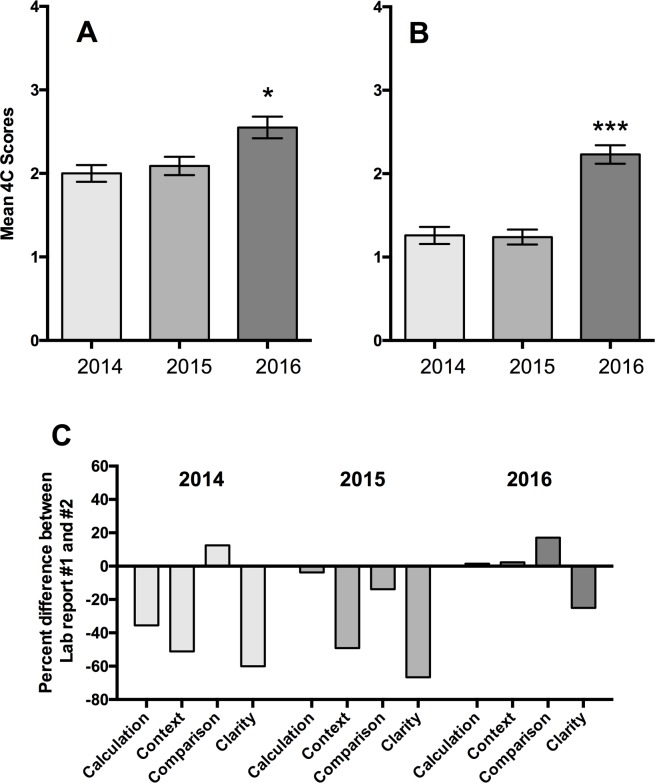
Analysis of native writing samples (lab reports).(A) Mean 4C scores of QC statements from lab reports (enzyme kinetics). (B) Mean 4C scores of QC statements from second lab reports (transcriptional regulation). (C) Percent difference between the two lab reports within a given year, broken down by essential components (*p < 0.05, ***p < 0.001) Error bars in A and B represent SEM.